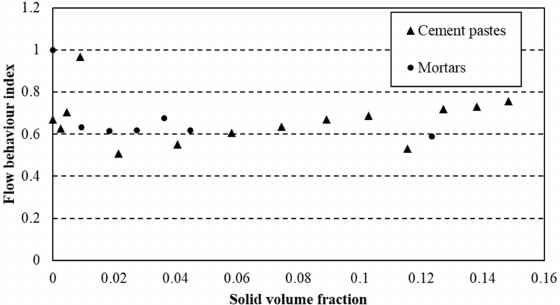
Figure 7. Flow behaviour index n for cement pastes and mortars.